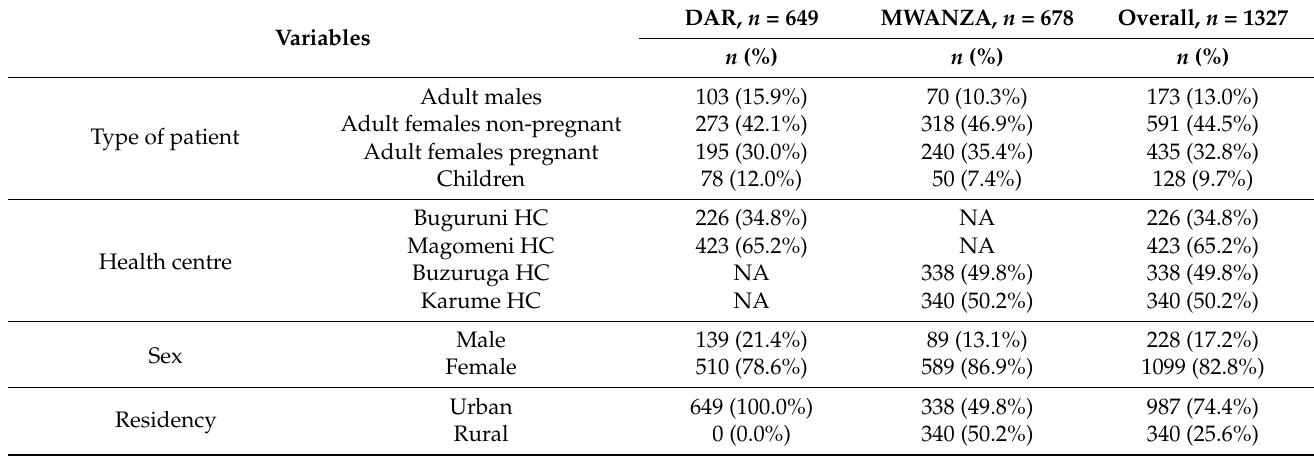
Table 1. Patients’ socio-demographic and clinical